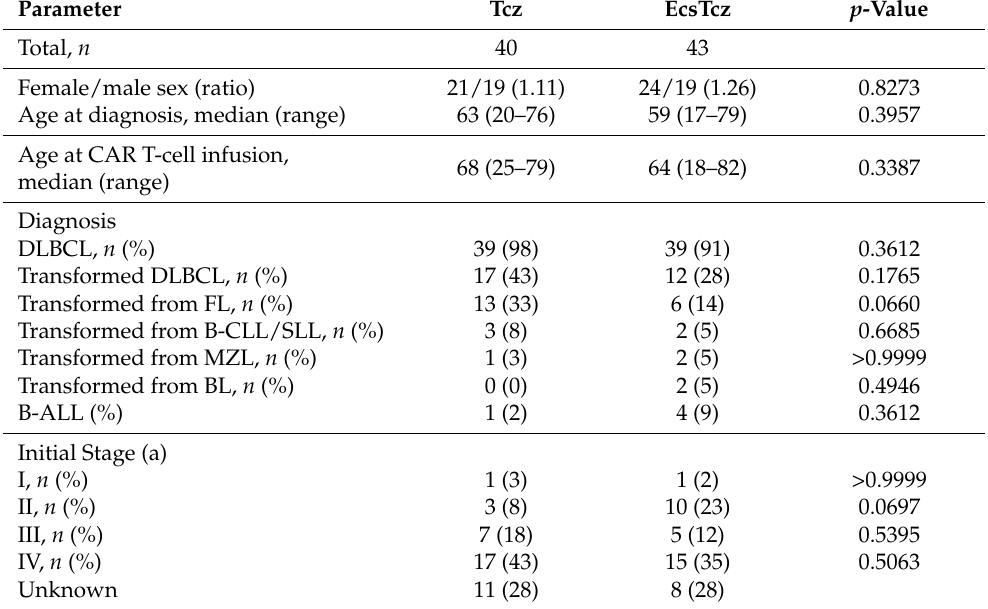
Table 1. Comparison of baseline clinical characteristics before CAR T-cell therapy in the Tcz vs. EcsTcz